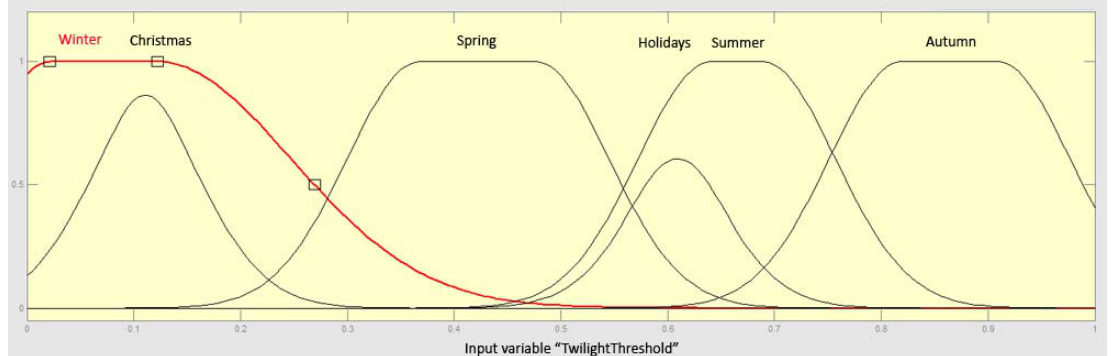
Figure 17. Fuzzy sets referring the twilight threshold (first input variable of the ANFIS).